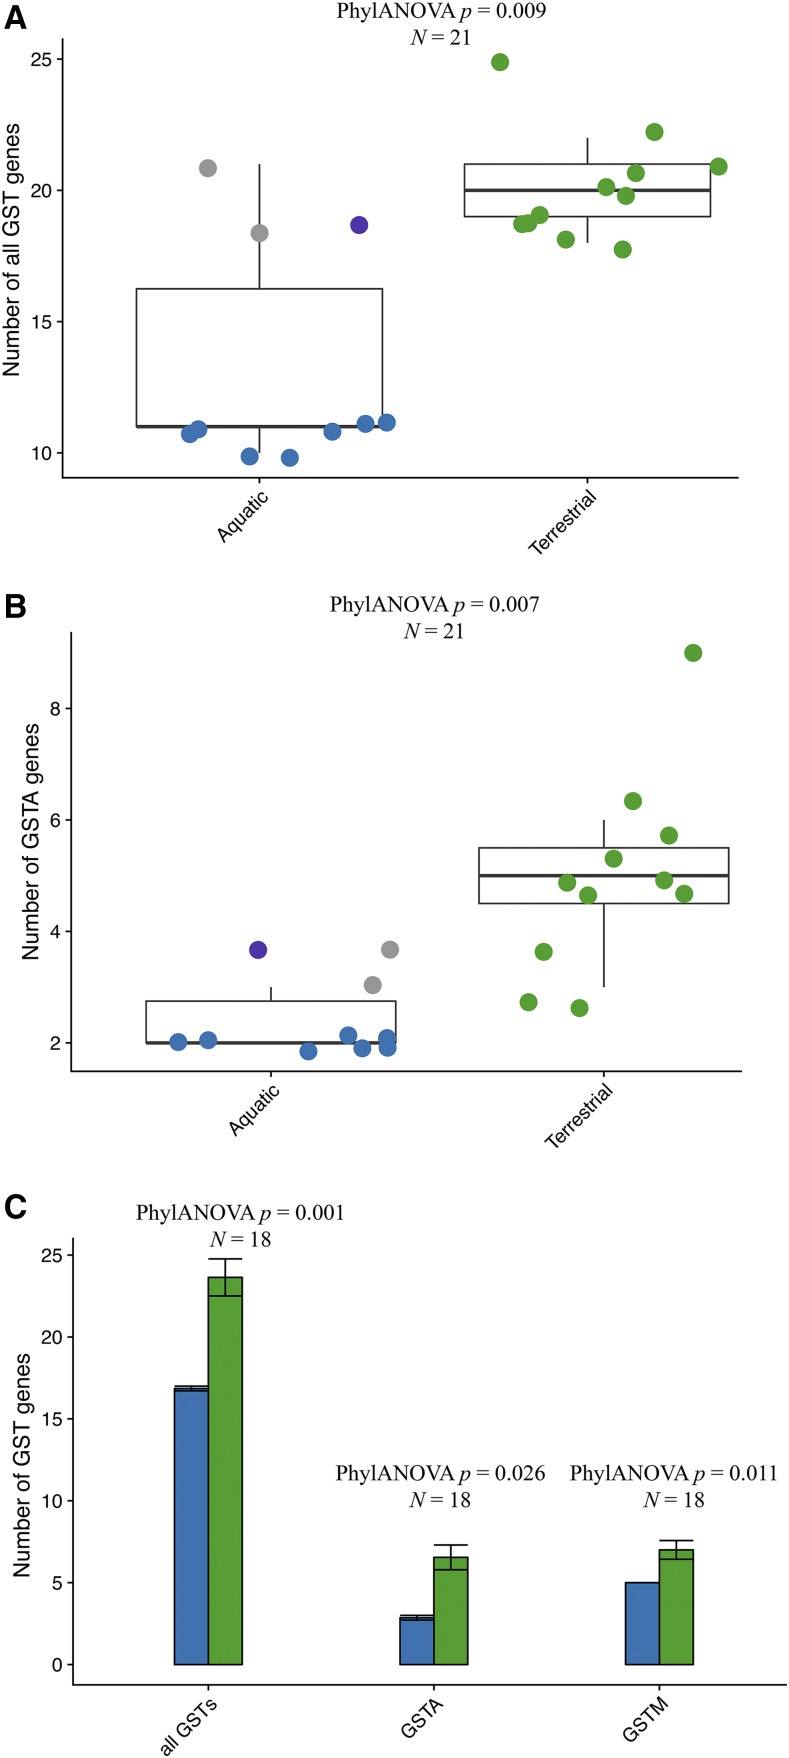
Differences in cytosolic GST genes between mammals inhabing aquatic and terrestrial habitats. (A) All GSTs genes combined, comparing aquatic and terrestrial mammals. Green dots indicate terrestrial species; blue dots, cetacean species; gray dots, pinnipeds; purple dots, sirenians. (B) alpha-class GSTs (GSTA) genes, comparing aquatic and terrestrial mammals. Annotated as in (A). (C) Comparison of all GST genes, alpha-class GSTs (GSTA) genes, and mu-class GSTs (GSTM) genes in ceteaceans and terrestrial mammals. Bar chart shows mean± SEM. Blue bars indicates cetacean species; green bars, terrestrial species. We compared each pair of distributions by phylogenetic ANOVA (phylANOVA) tests, which control for shared ancestry. The p-value for each test is shown above each plot.